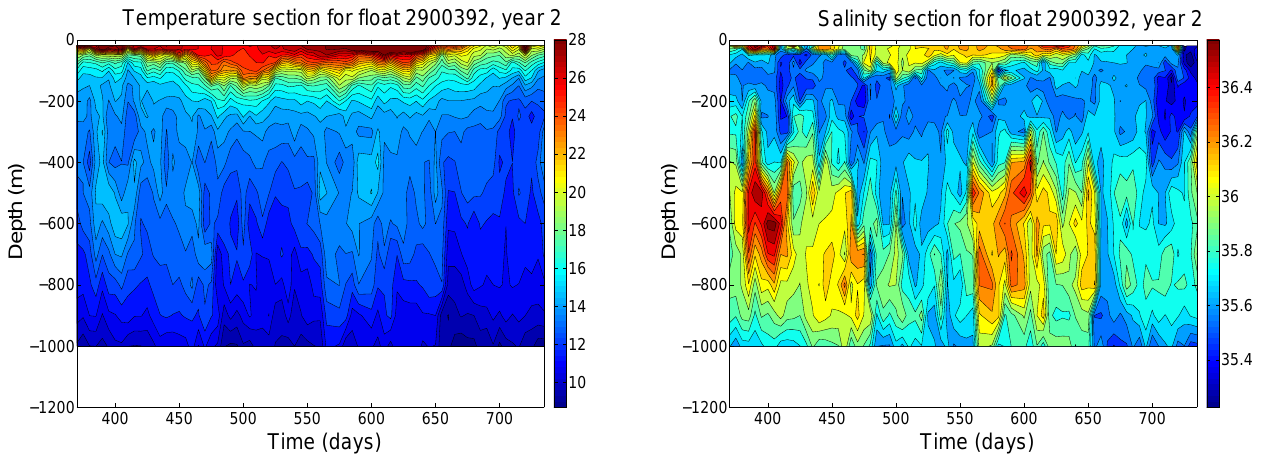
Fig. 12. Vertical sections of temperature (in ◦ C, left) and of salinity (right) along float 2900392 trajectory for year 2. Figure 12: Vertical sections of temperature (in o C , left) and of salinity (right) along float 2900392 trajectory for year 2.